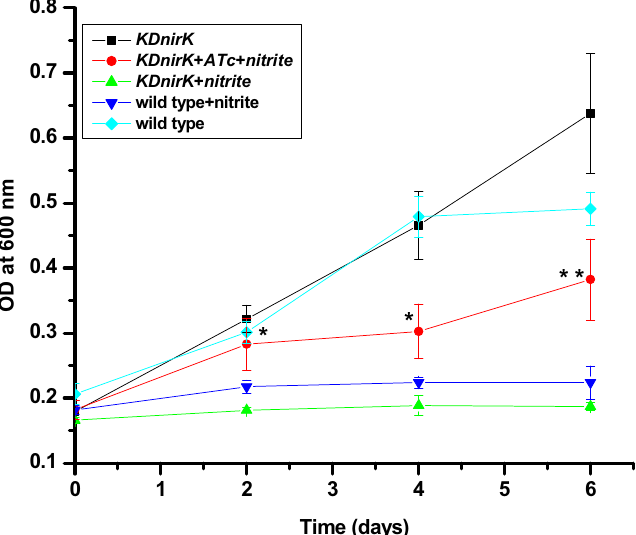
Figure 8. Effect of nitrite on growth of Mycobacterium tuberculosis KDnirK clone : Log phase cells of KDnirK (black filled square), KDnirK induced ATc with 10 mM of nitrite (black filled circle), KDnirK cells with 10 mM of nitrite without ATc (black filled triangle), wild type treated with 10 mM of nitrite (black filled inverted triangle) and wild type (black filled daimond) Mtb culture were incubated at 37 °C. The growth kinetics was monitored by measuring OD 600 nm at different time point. The data represented as mean of two independent experimental results with (± SEM). Asterisks (*and **) indicating the significance difference between KDnirK induced cells with nitrite treated to KDnirK nitrite strain. Model 1: Synthesis of NO and its role in infected Mycobacterium tuberculosis NO and superoxide are produced from infected/Activated macrophage by iNOS and NADH oxidase ( Nox ) respectively. The reaction between NO and superoxide form peroxynitrite which is subsequently converted to nitrate and passively move ↑ inside phagosome. Under hypoxic condition, this nitrate further transport inside Mtb cells and utilized by narG to form nitrite. This increased nitrite facilitates further the entry of nitrate inside the bacillus through narK2 antiport while nirK reduces nitrite to NO as a mechanism of maintaining long-term latency inside human